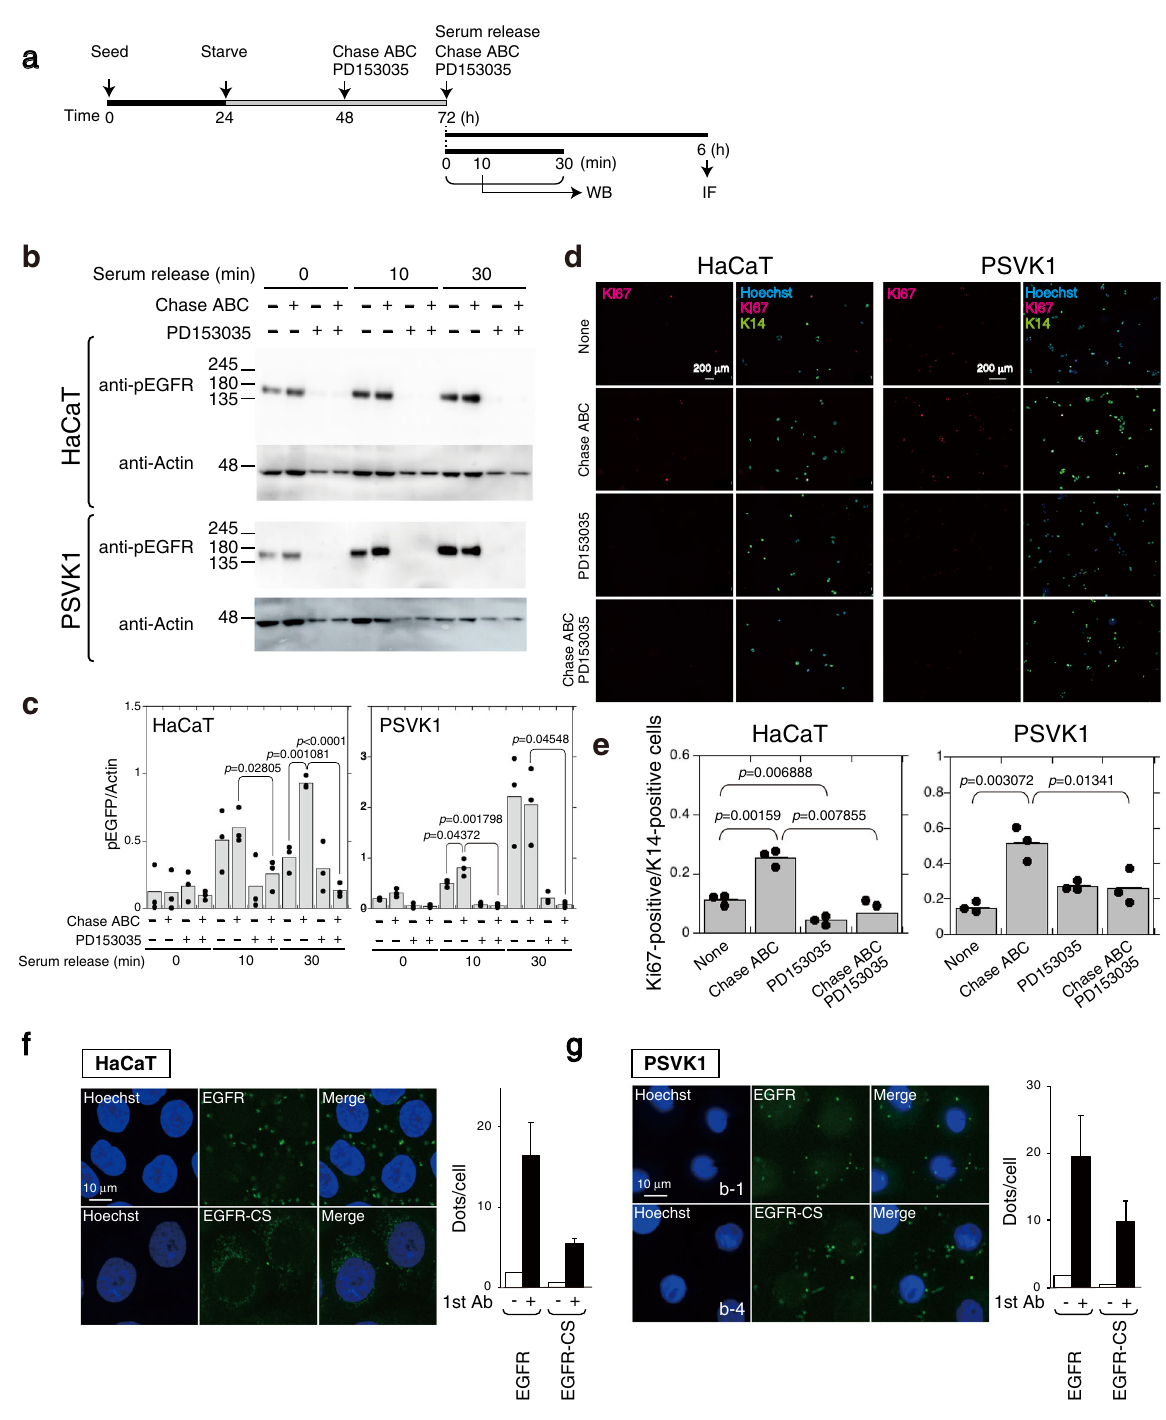
Fig. 7 Proliferation of cells from human keratinocyte clone lines, HaCaT and PSVK1, is regulated by CS. a Schematic diagram of experimental work fl ow. b HaCaT cells (2 × 10 4 cells/dish) and PSVK1 cells (1.7 × 10 5 cells/dish) were seeded, and starved for 48 h prior to allowing cell cycle progression via addition of serum in the presence of 2.5 munits/mL of Chase ABC and 5 μ M PD153035, and culturing cycling cells for the indicated time. Proteins extracted from HaCaT and PSVK1 cells were analyzed by immunoblotting using anti-phospho-EGFR (p-EGFR), and anti-EGFR antibody. c Densitometric analysis of the levels of phospho-EGFR compared with levels of actin is shown. Bars represent the means ± S.D. from three independent biological replicates. Statistical signi fi cance of differences was determined using Student ’ s t test. d HaCaT (1 × 10 4 cells/well) and PSVK1 cells (2.5 × 10 4 cells/well) were cultured in the presence or absence of Chase ABC (2.5 munits) and PD153035 (5 μ M), and stained with anti-K14 and anti-Ki67 antibody. Nuclei were counterstained with Hoechst33342. e Quanti fi cation of Ki67- and K14-double positive keratinocytes is shown. Values are mean ± S.D. from three independent biological replicates. Statistical signi fi cance was determined using Student ’ s t test. Direct interactions between EGFR and CS-C (EGFR-CS) and EGFR homodimers in HaCaT ( f ) and PSVK1 ( g ) cells were detected by PLA assay. The graph shows means ± S.D. of EGFR homodimer and EGFR-CS signals (green dots)/cell counted from three independent